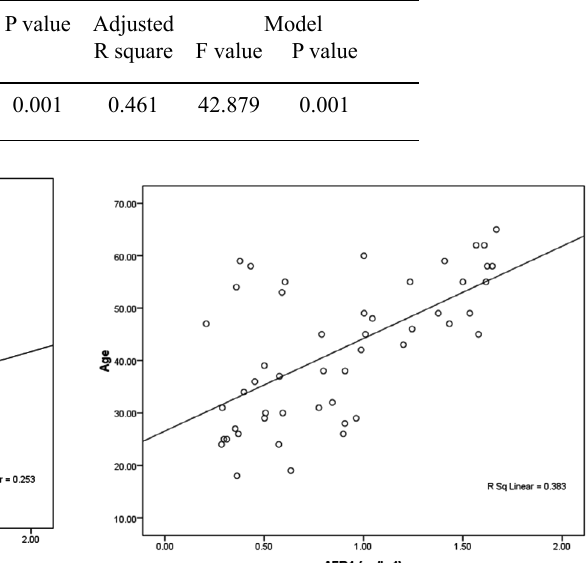
Fig. 3. Correlation between AFB1 (µg/L-1) and AST (µ/L) with best fit line curve (positive correlation)